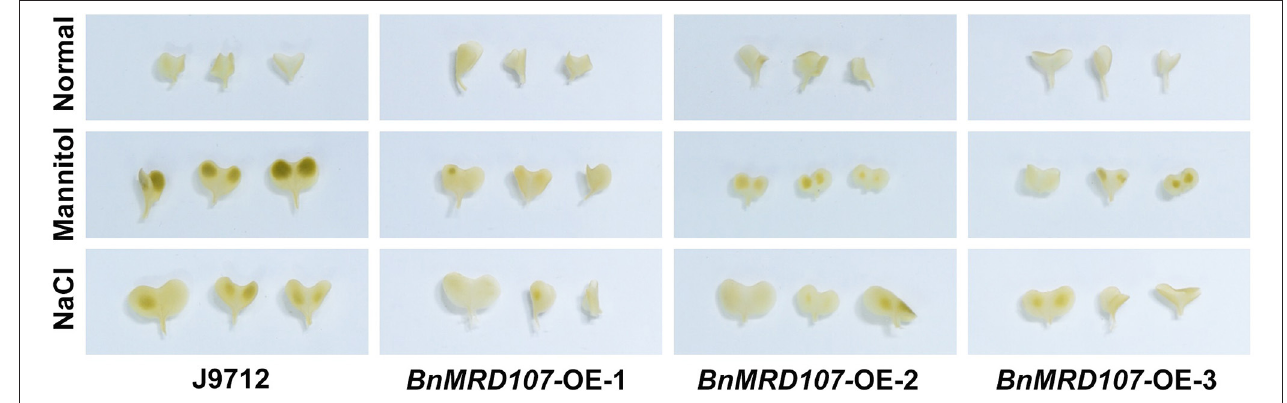
FIGURE 10 | DAB-staining of cotyledons from J9712 and BnMYBR107 -OE plants under normal conditions, osmotic stress, and salt